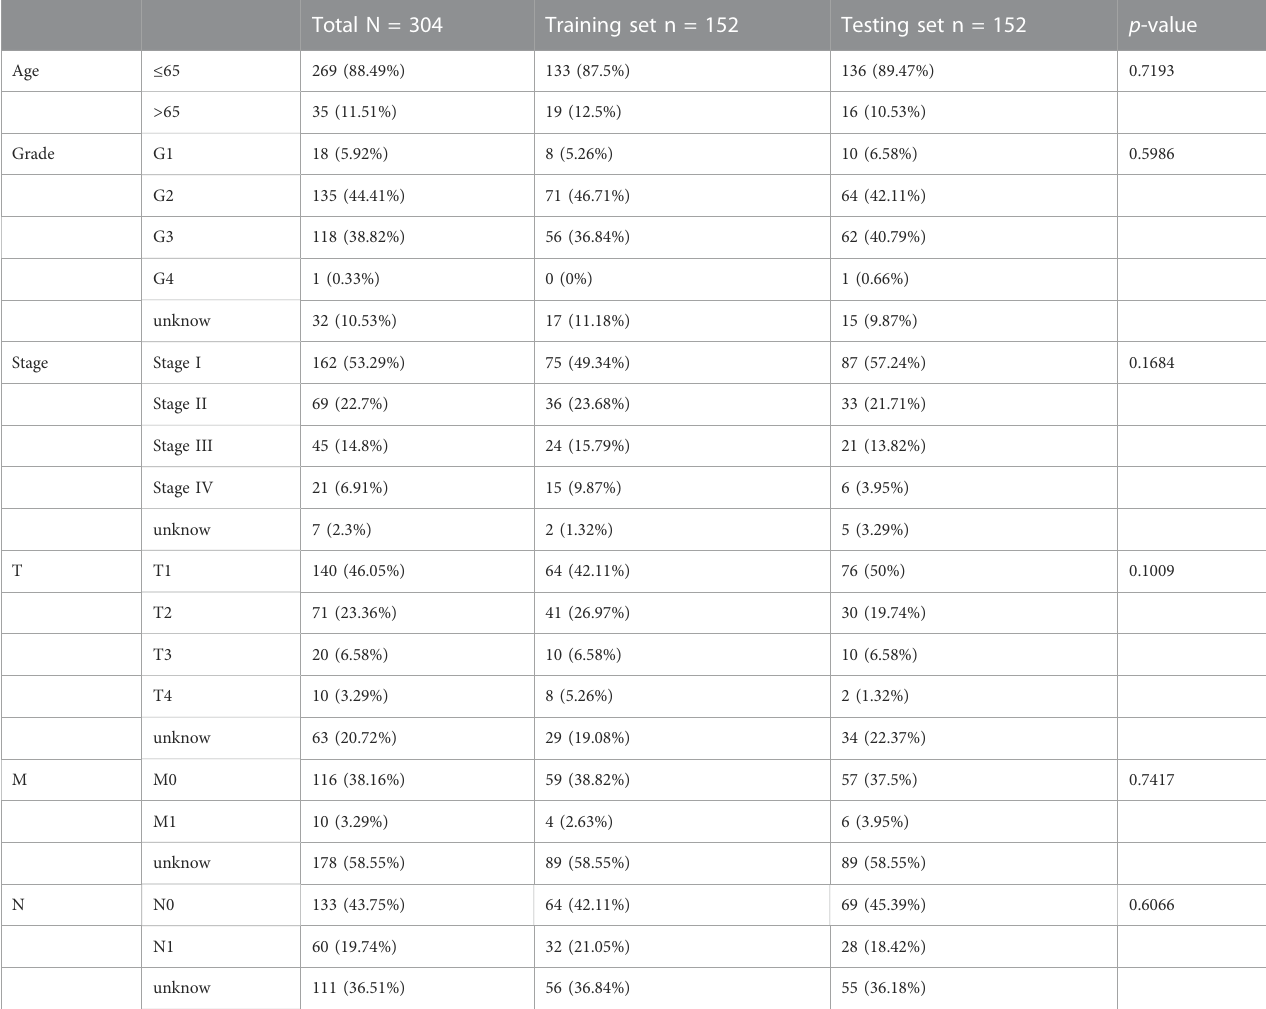
TABLE 1 Clinical characteristics of CESC patients involved in the